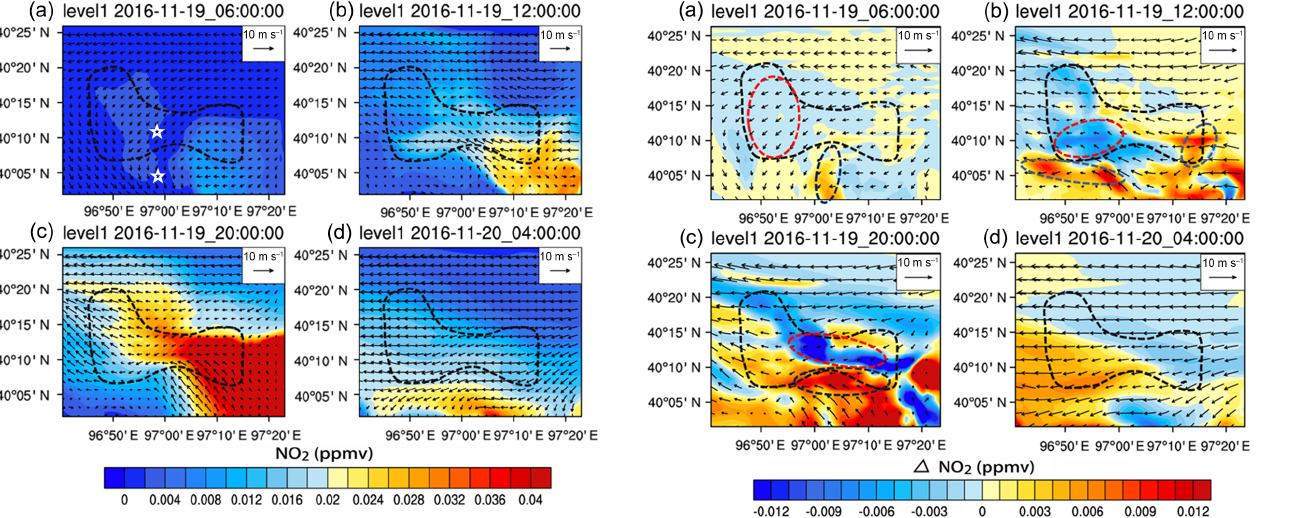
Figure 6. Differences of modeled NO 2 concentrations (ppmv) be- tween S2 model run and control run (S1) at 06:00, 12:00, and 20:00UTC on 19 November and 04:00UTC on 20 November. The wind field is the same as that shown in Fig. 3, and YWF is encircled by black dashed line. The differences were calculated by S2 − S1. The deep blue and red dashed lines encircled relatively higher and lower values of the concentration differences.